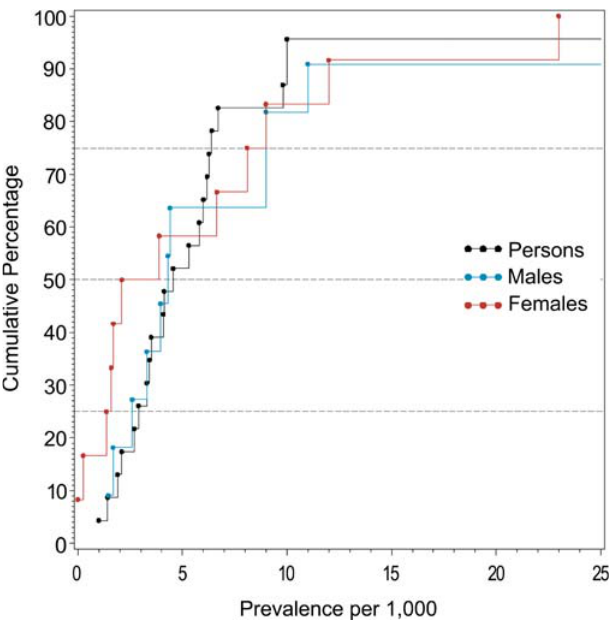
DOI: 10.1371/journal.pmed.0020141.g002